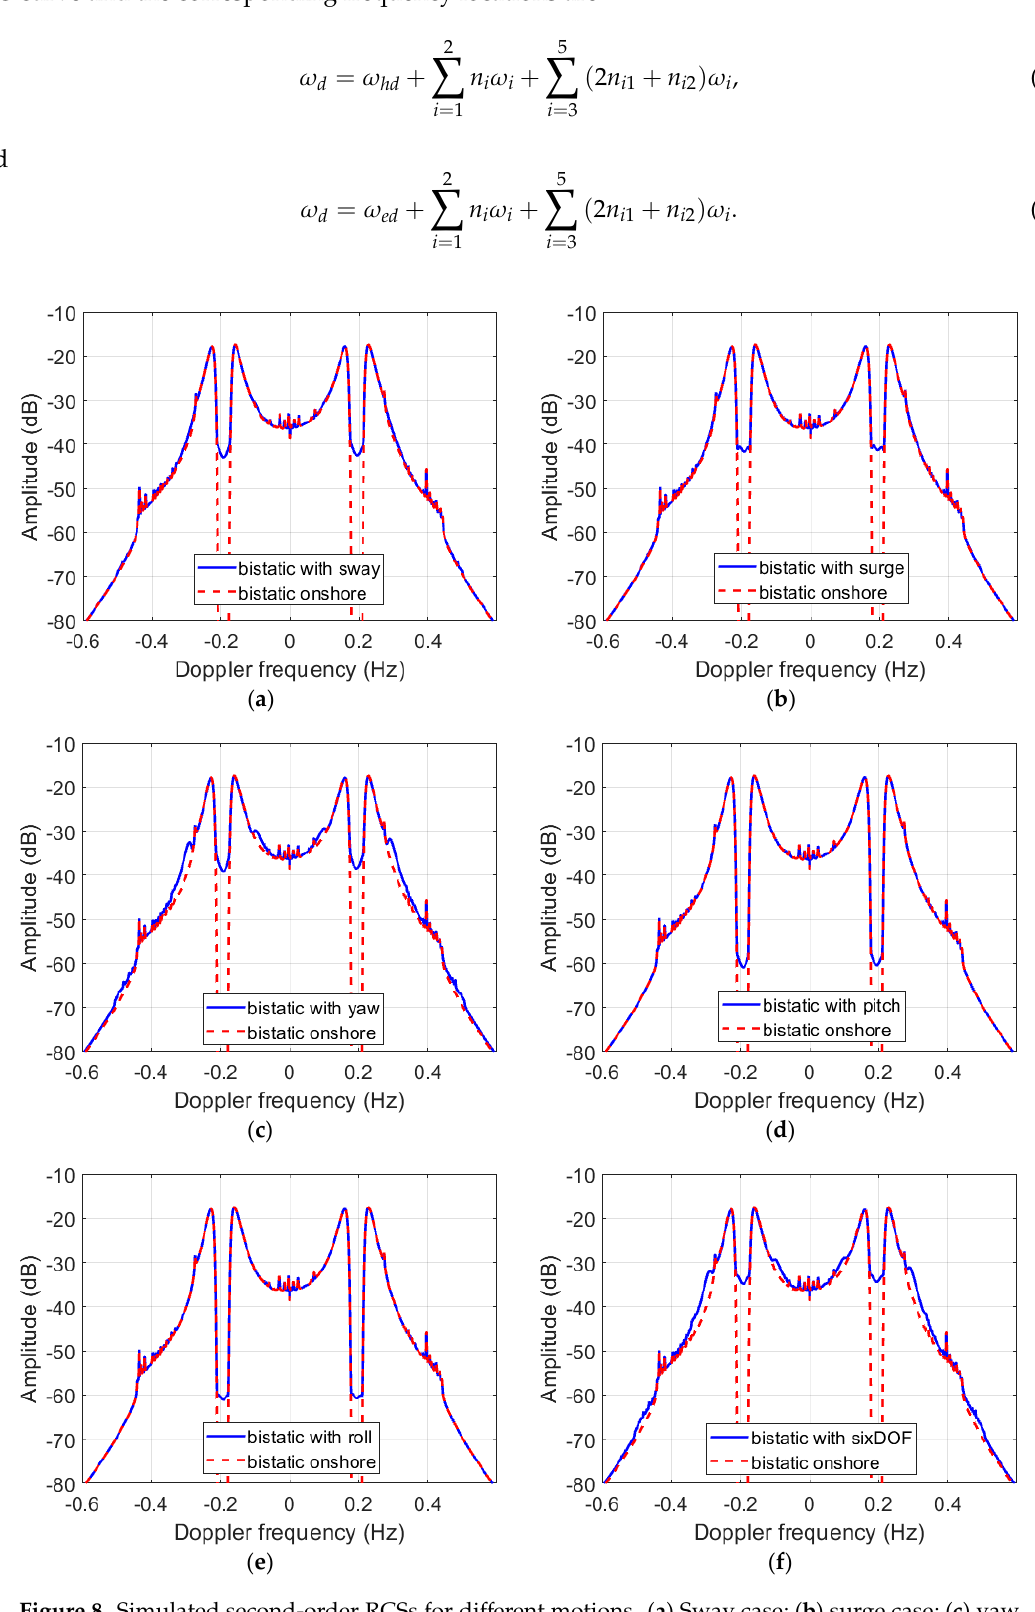
Figure 8. Simulated second-order RCSs for di ff erent motions. ( a ) Sway case; ( b ) surge case; ( c ) yaw